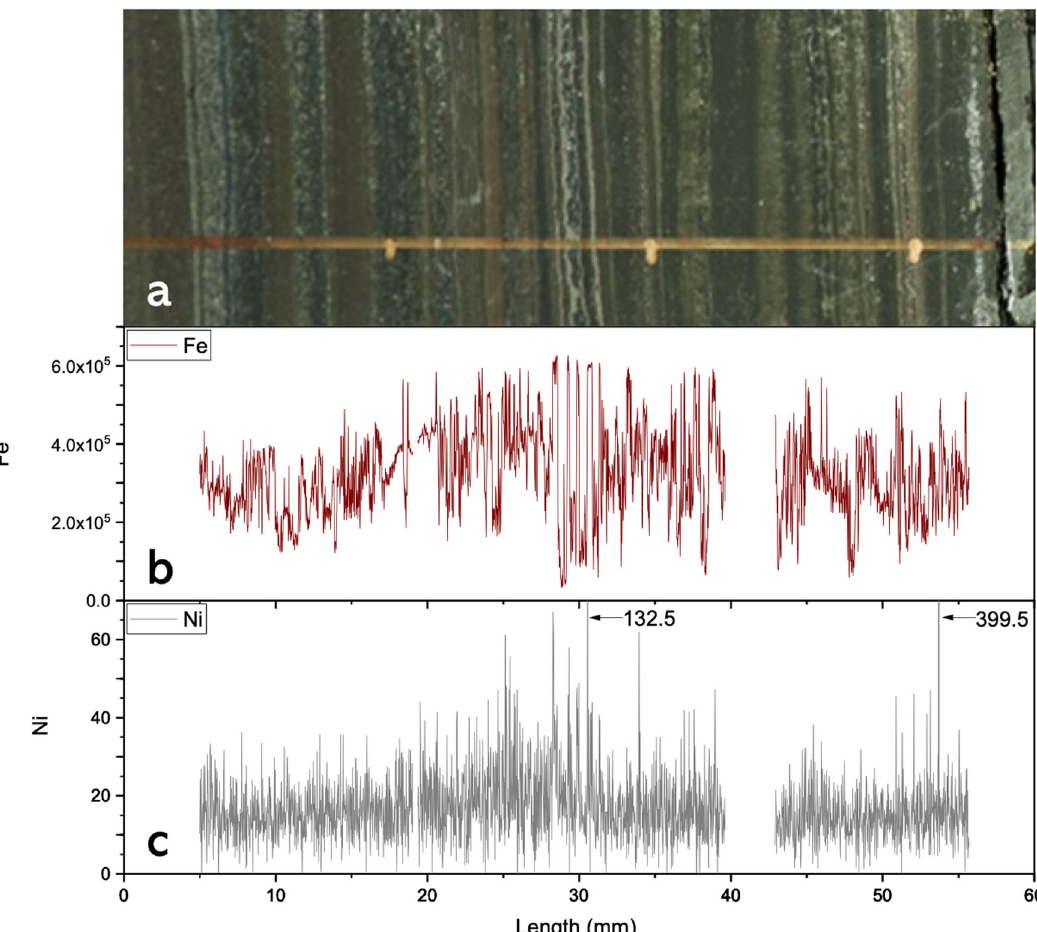
Fig. 1 Microbanded Kuruman BIF drill core sample with its Fe and Ni elemental spectra in cps. a Microbanded Kuruman BIF drill core sample. The intervals denoted by yellow dots represent 17 mm segments. b , c Fe and Ni elemental spectra of the sample in cps. Segments of systematic measuring anomalies (0 – 4.96 mm, 19.02 – 19.34 mm, 39.64 – 42.90 mm, and 55.70 – 59.42 mm) were removed. Two points have Ni concentrations much larger than the others, as denoted by the